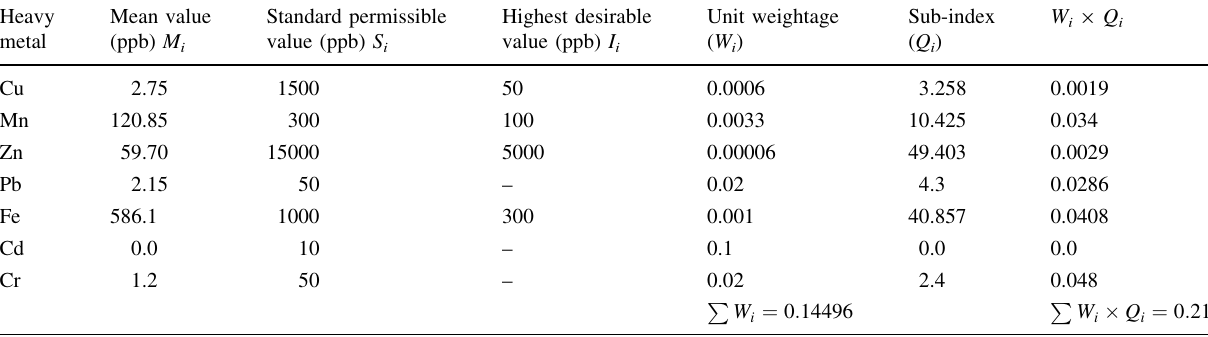
Table 4 HPI calculation for groundwater of Dhanbad Town in 2014 Heavy